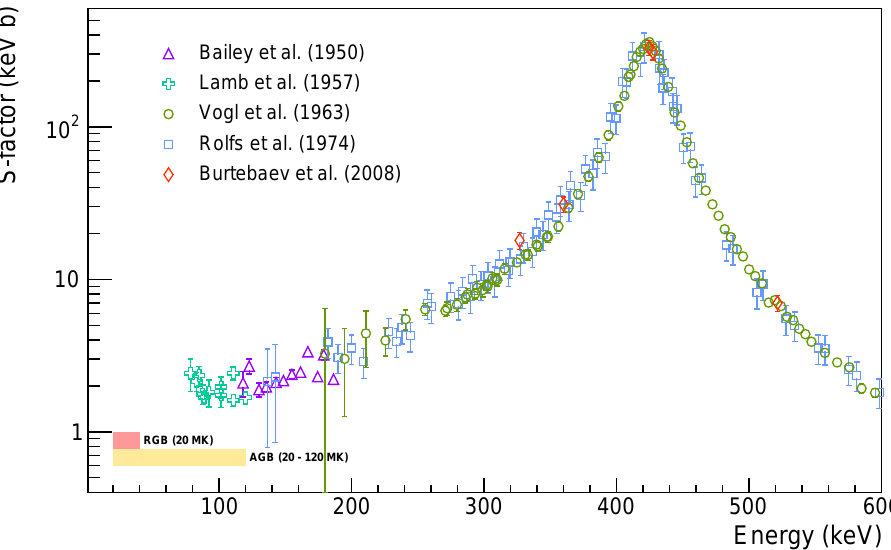
Figure 1: State of the art for the 12 C(p , γ ) 13 N reaction cross section. Two di ff erent energy ranges of interest are highlighted for RGB and AGB stars, respectively. Direct data available in these energy ranges comes from early measurements with significant scatter and uncertain-